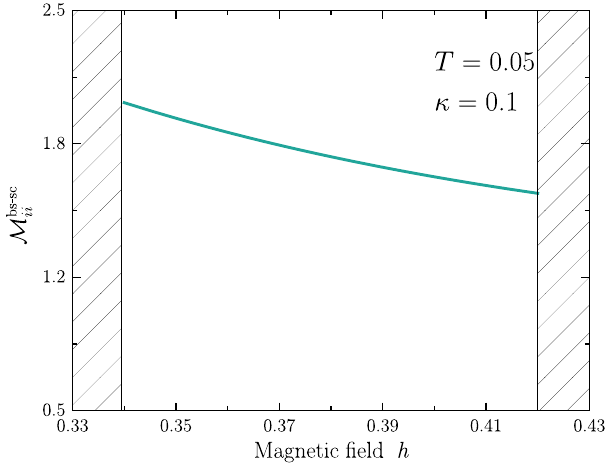
FIG. 8. Magnetic field dependence of diagonal mass tensor elements M bs − sc for a Skyrmion with κ ¼ 0 . 1 , at temperature ii T ¼ 0 . 05 and for S ¼ 1 and ~ J= ~ D ¼ 4 . The magnetic field region where bound states contribute to the mass is bounded by the critical field below which the Skyrmion becomes unstable (left vertical line) up to the field where the bound state energy passes to the continuous spectrum (right vertical line).